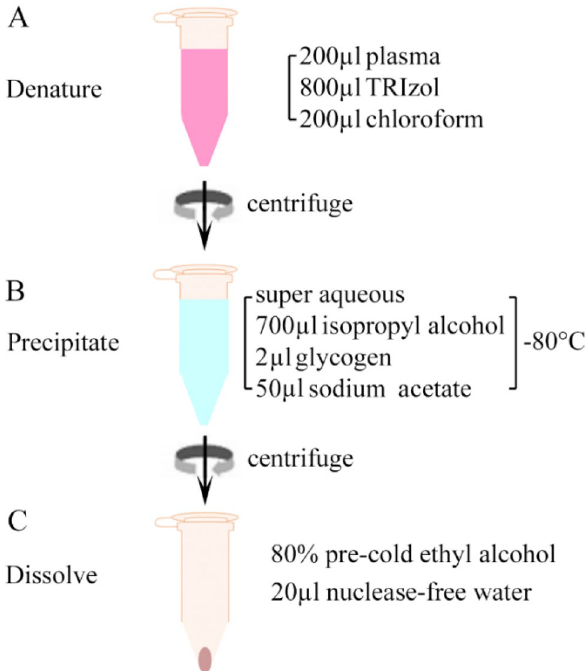
Figure 1. The principle and workflow of the optimized TFP method with specific reagents in the denaturing ( A ), precipitation ( B ), and washing/dissolving ( C )